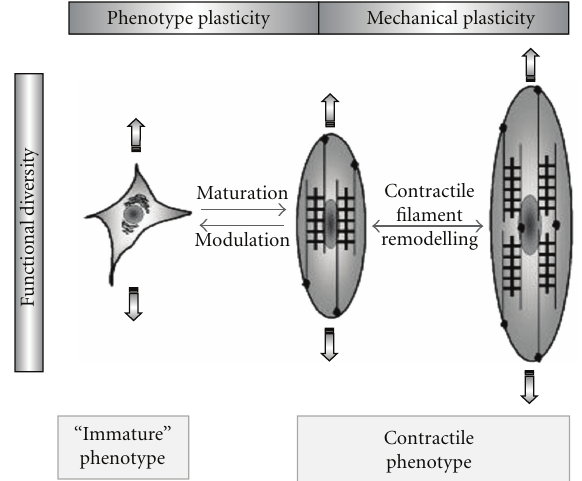
Figure 1: Correlation of phenotype, mechanical and functional plasticity of VSMCs (figure from